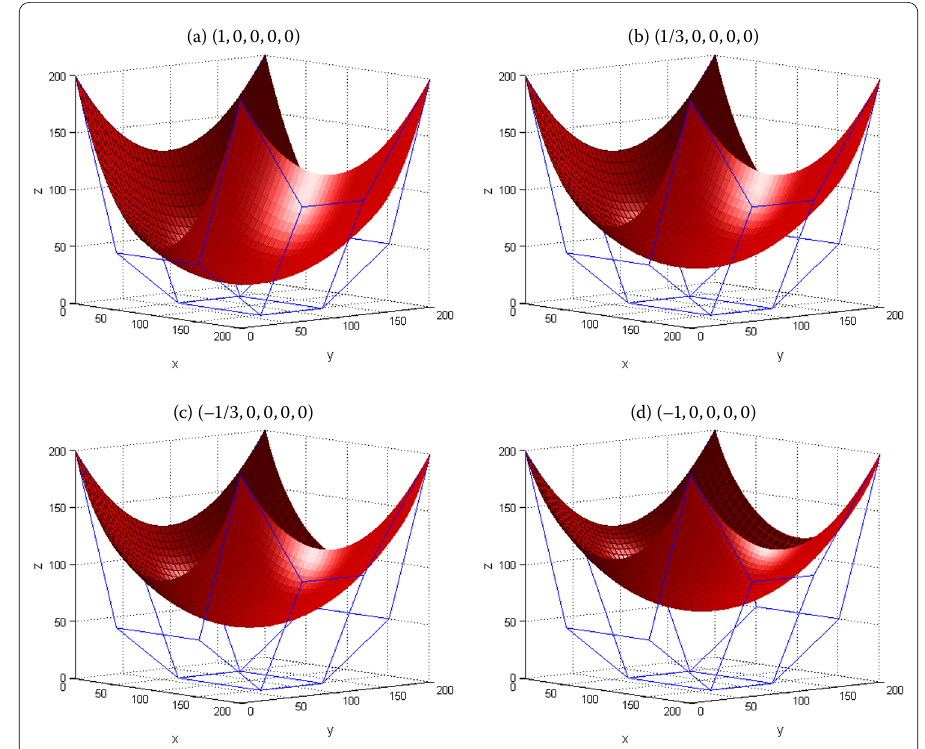
Figure 2 Generalized Bézier-like surfaces of degree (3,3) with different shape parameter λ